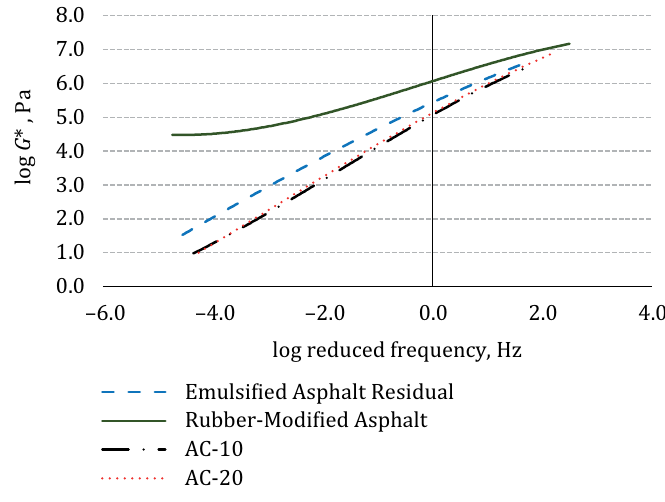
Figure 4. G * master curve of four different